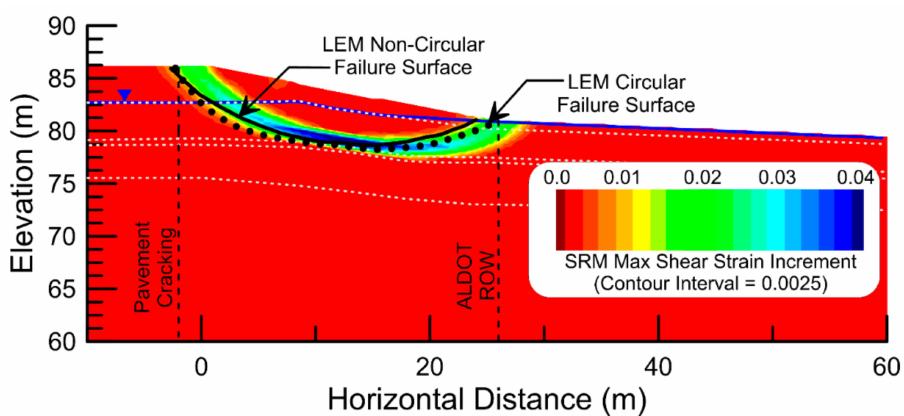
Figure 7. Maximum shear strain interval contours (zoomed in on failure surface location) from SRM analysis using fully softened drained strengths with critical noncircular failure surface from LEM shown as solid black line and critical failure surface from LEM with circular surfaces shown by dotted black line. Locations of ALDOT ROW and observed pavement cracking are shown as dashed lines. Soil boundaries (Figure 2) are shown by dotted light grey